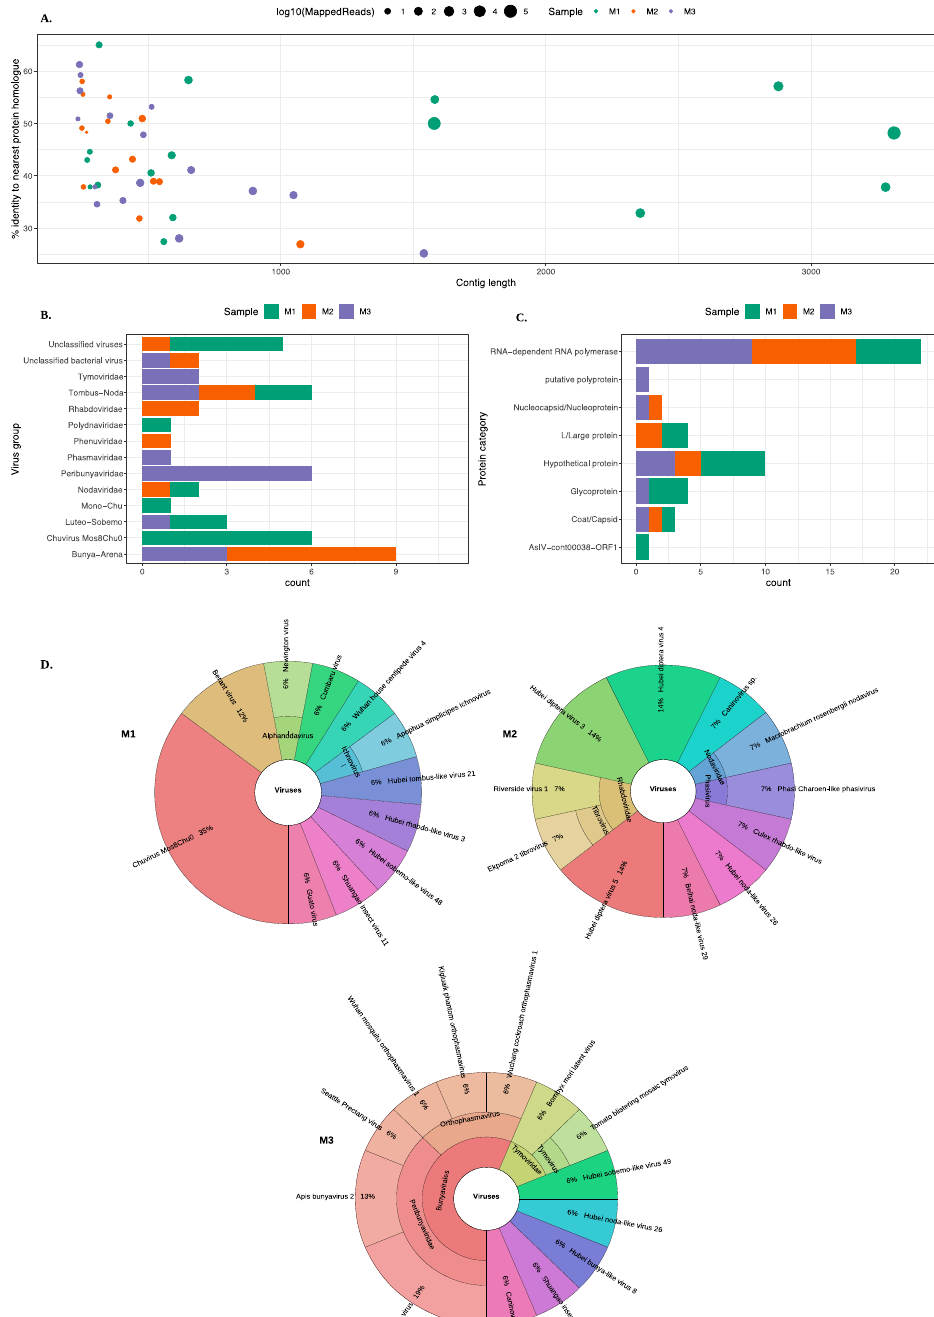
Figure 2. An overview of the virus hits found in all midge pools. ( A ) A scatter plot showing contigs lengths (x-axis) and the corresponding percent identity (y-axis) for the top BLAST hit. The colour of the circle represents the midge pools and the size of the circle represent the number of mapped reads on a log10 scale. ( B ) A bar chart describing di ff erent virus groups found in the midge pools where each pool is represented in a di ff erent colour. ( C ) A bar chart showing di ff erent proteins found in the midge pools characterised based on the nearest BLAST homologue. The virus classification groups and protein categories were derived based on the closest viral sequence match. ( D ) Distribution of the closest viral homologs found in the midge pools. Krona plots show the nearest virus hit found in all three midge pools, M1, M2 and M3 respectively. Colours in the Krona charts represent the distinct taxonomic